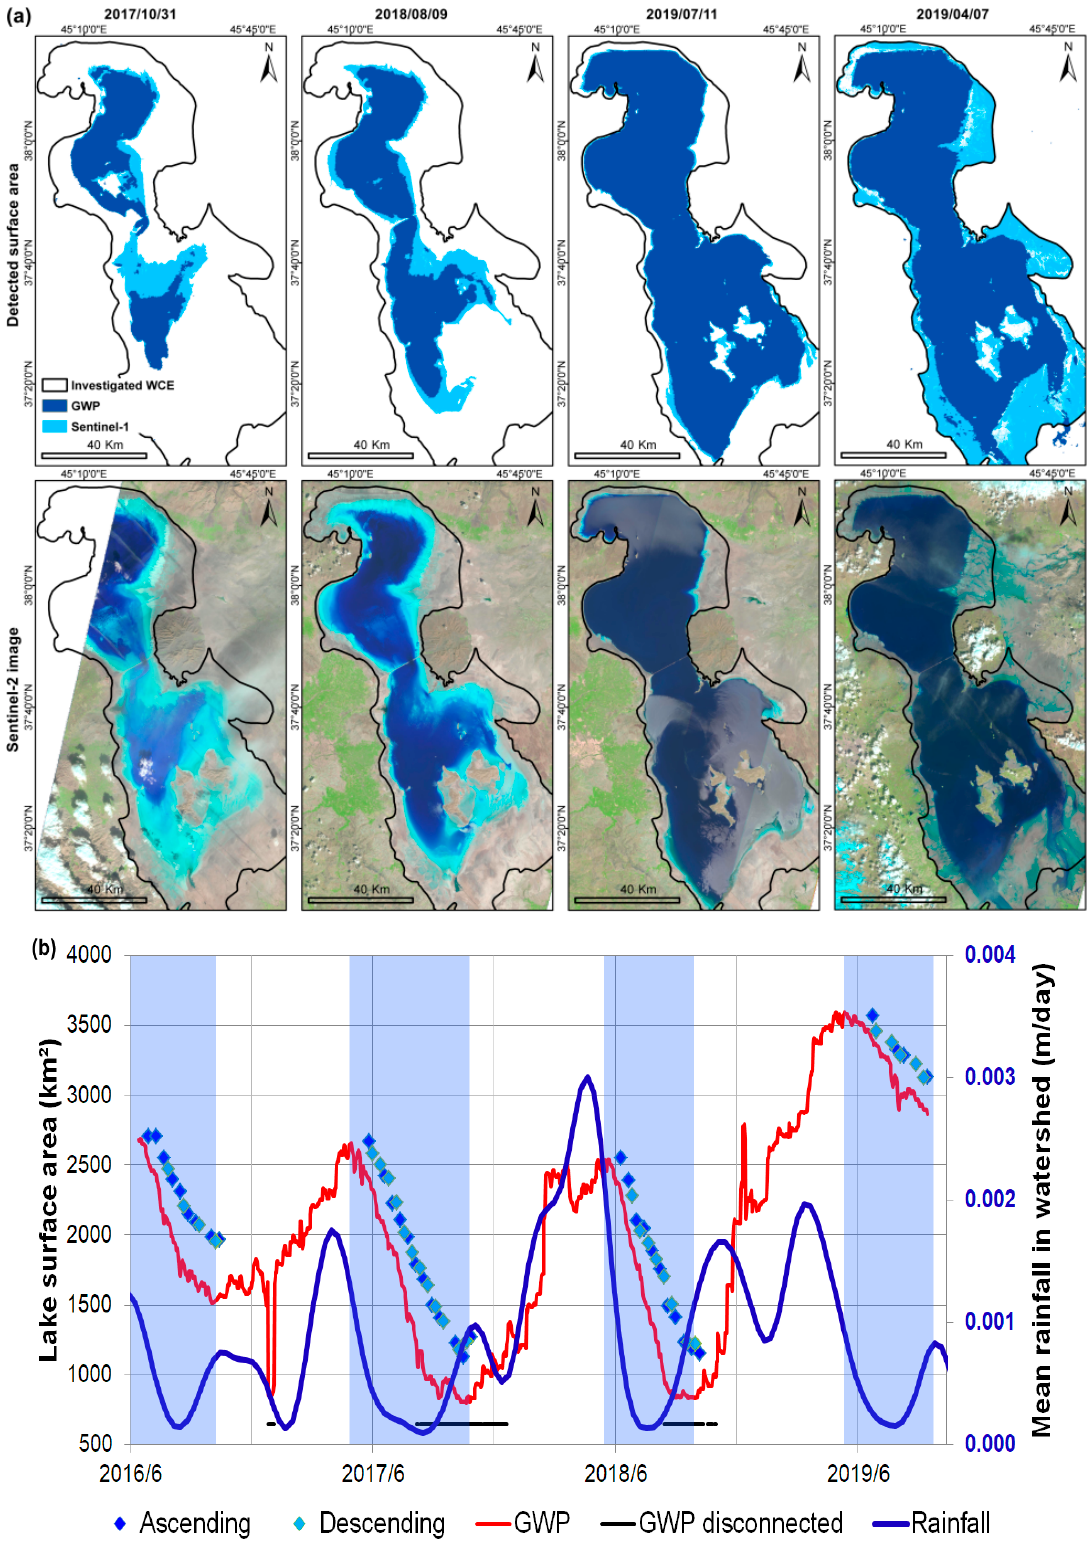
Figure 16. ( a ) The comparison of the surface area of Lake Urmia detected by Sentinel-1 SAR imagery and the GWP product and the same date high-resolution Sentinel-2 imagery. The mean rainfall volume is plotted in ( b ) to identify the dry season, with the lake water depletion periods marked in blue boxes. The date that shows lake disconnection in the GWP is marked with black points in ( b ).